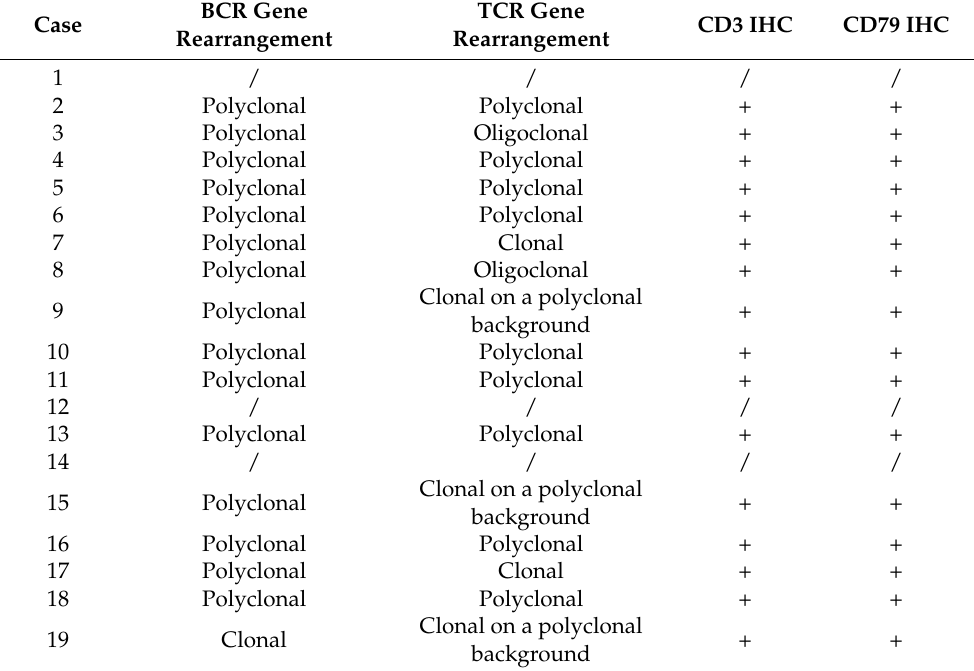
Table 4. Results of the molecular clonality analysis and immunohistochemical examinations